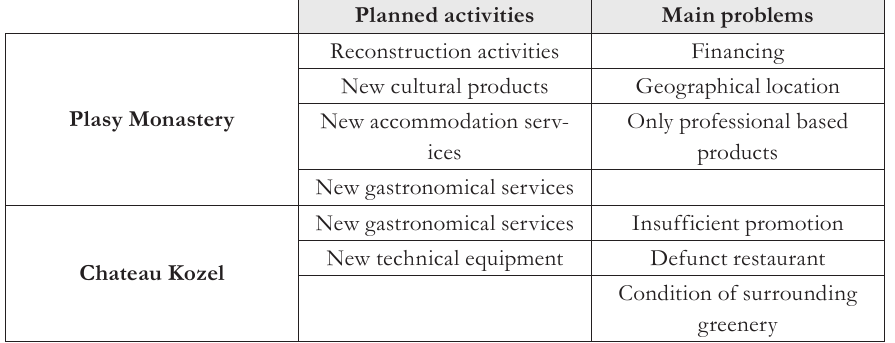
Tab. 3 - Results of the Survey. Source: Own